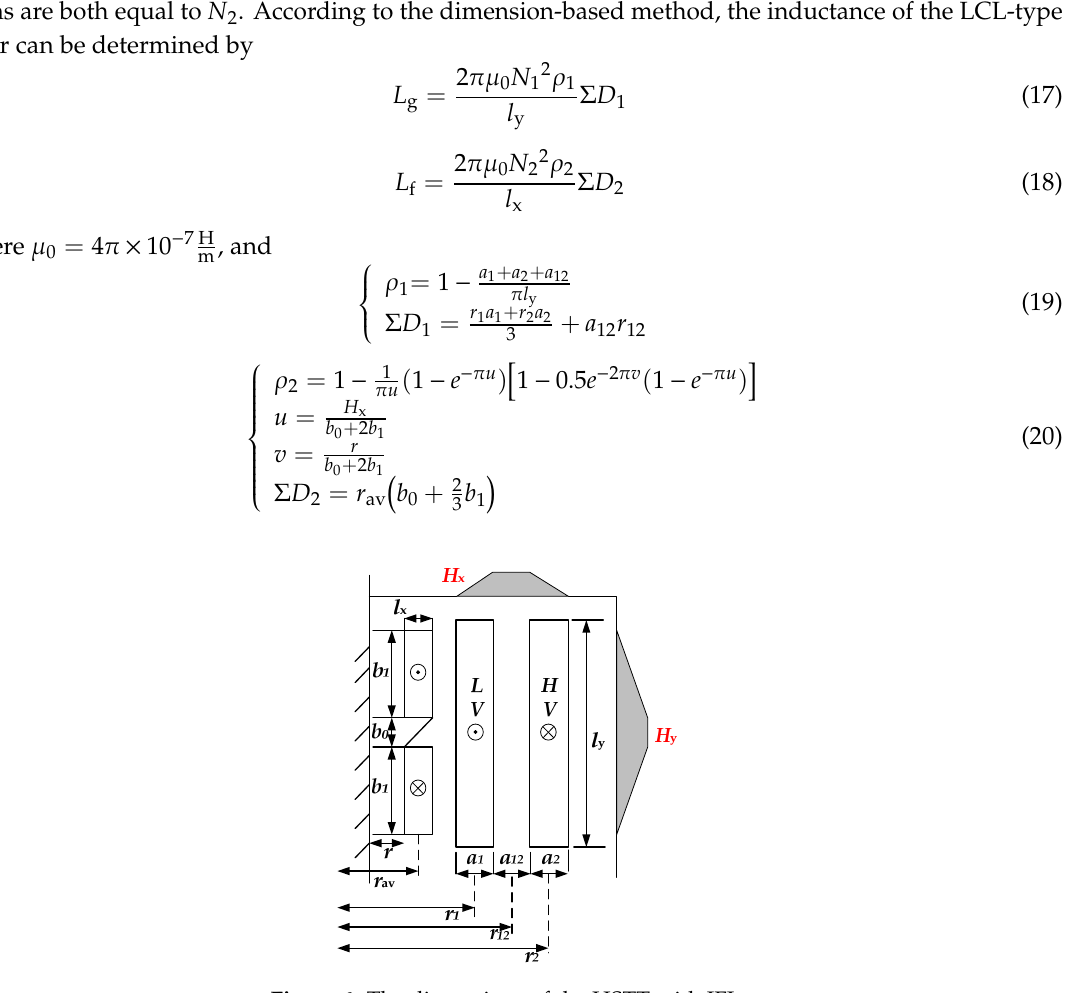
Figure 6. The dimensions of the HSTT with IFIs.